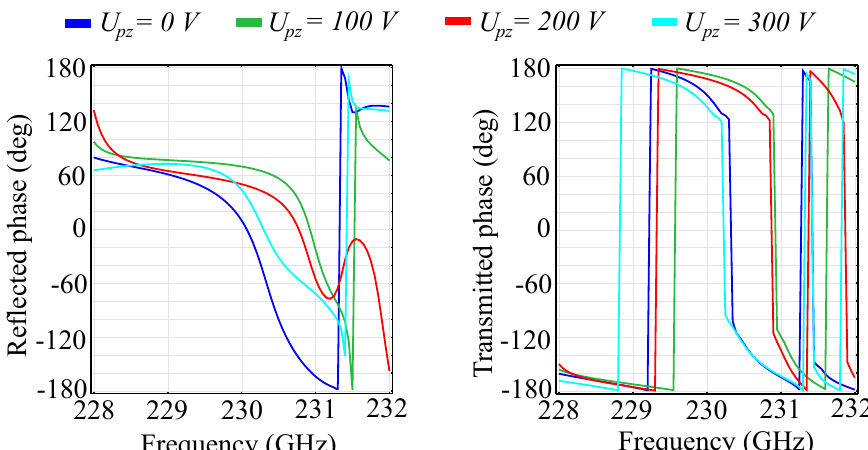
Figure 13. Simulated phase of the reflected and transmitted waves associated to the piezoelectric voltages applied longitudinally across the unit cell in the silicon substrate unit cell